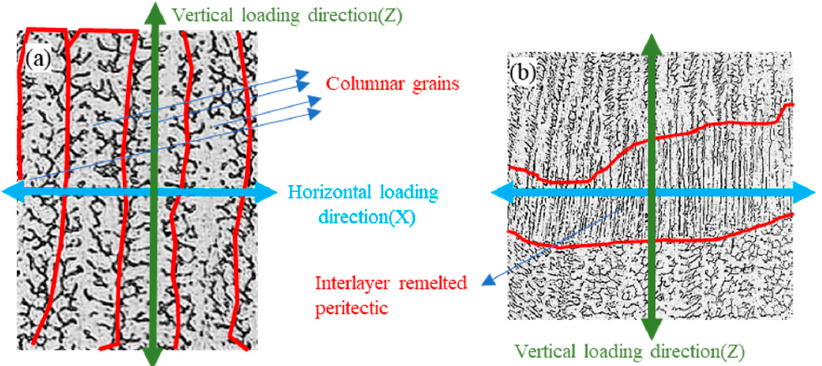
Figure 15. Relationships between tensile loading and: ( a ) columnar grain; and ( b ) interlayer remelted peritectic growth directions.